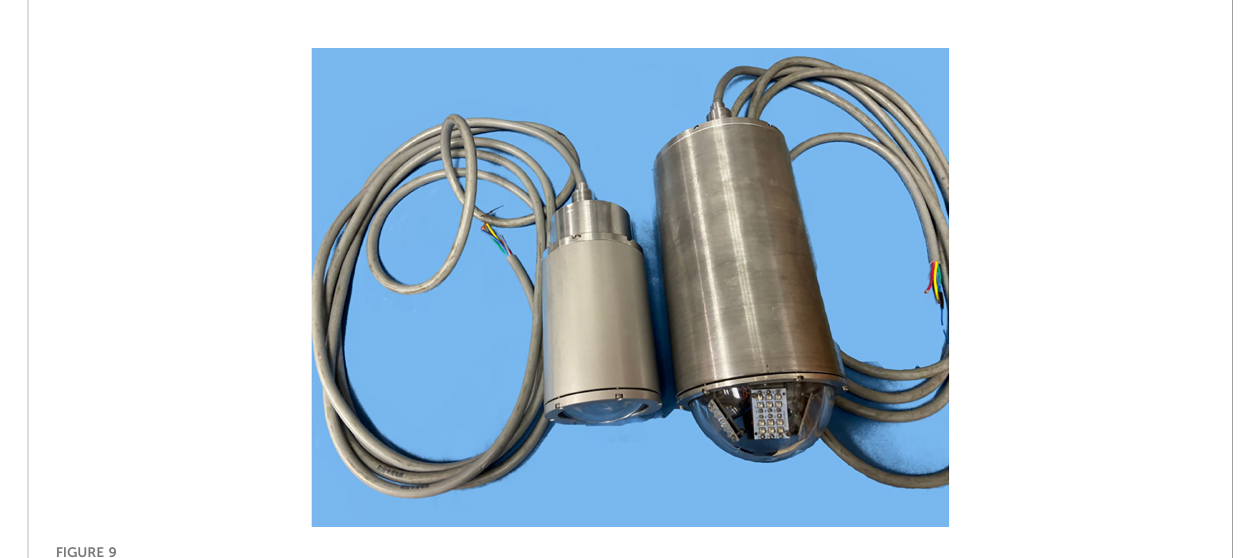
FIGURE 9 Prototype: receiver on the left and transmitter on the right.